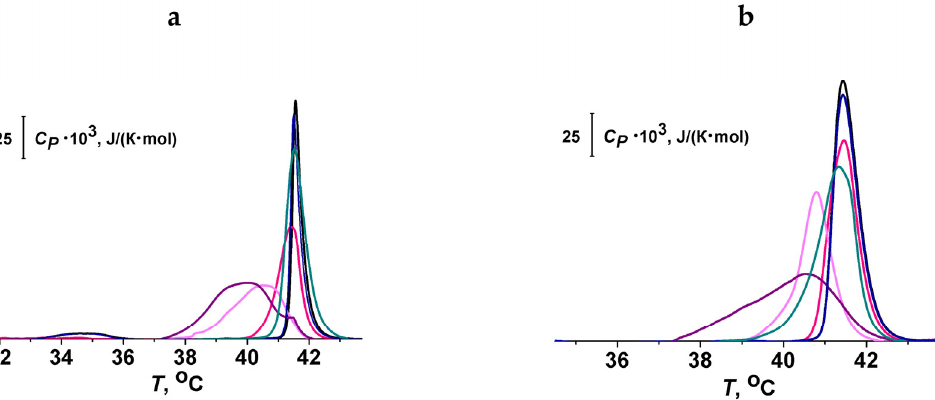
Figure 4. Heating thermograms of DPPC ( a ) and DPPG ( b ) (the dependence of specific heat at constant pressure, Cp, on the temperature, T) in the absence (black curves) and presence of polyphenols: piceatannol (purple curves), genistein (dark cyan curves), genistin (dark blue curves), catechin (pink curves), and taxifolin (magenta curves). The lipid:polyphenol molar ratio was equal to 10:1. Table 2. The parameters characterizing the effect of the polyphenols on thermogram phase behavior. DPPC